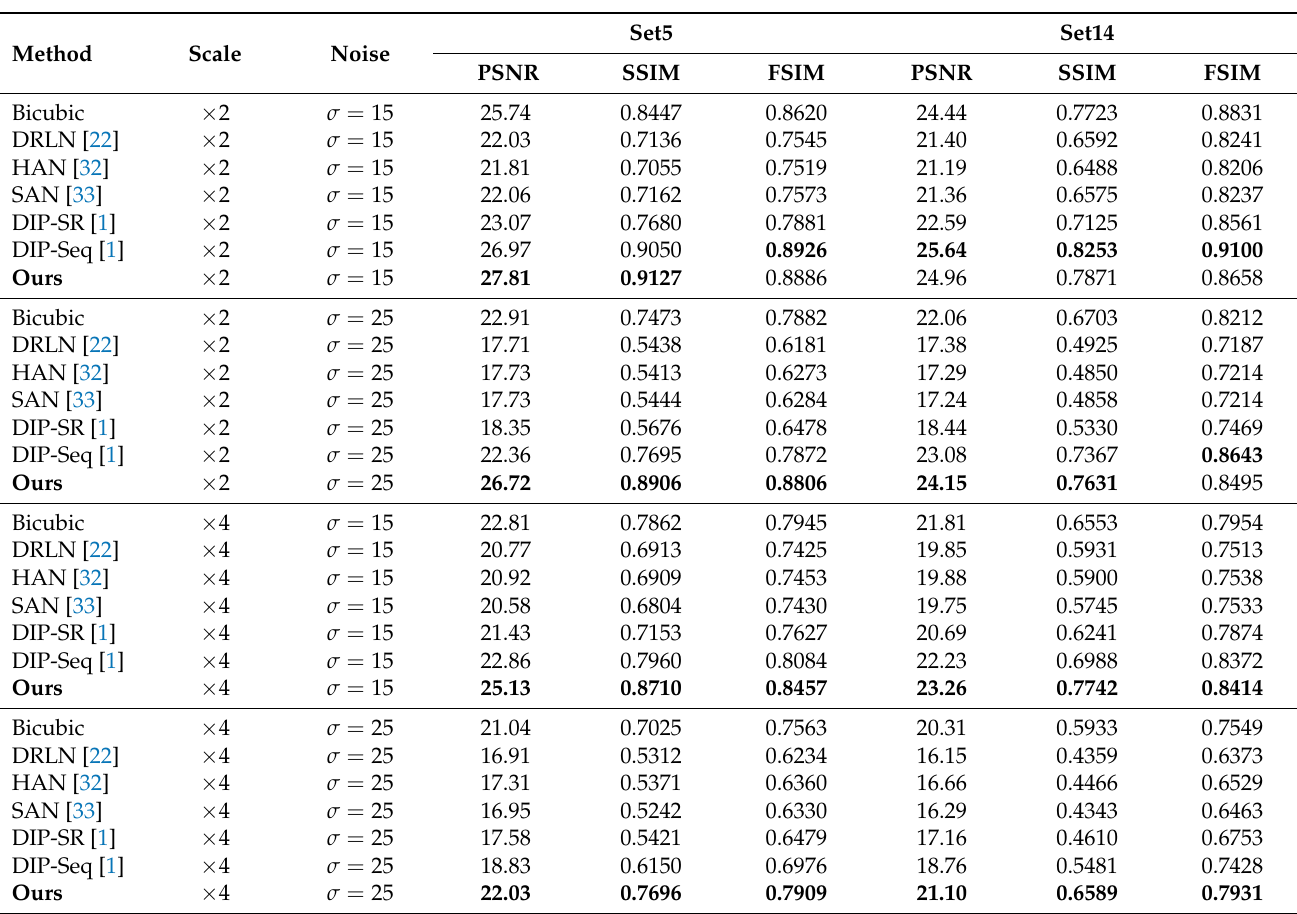
Table 1. Quantitative comparisons on Set5 [11] and Set14 [12]. The best results are highlighted in bold. Method